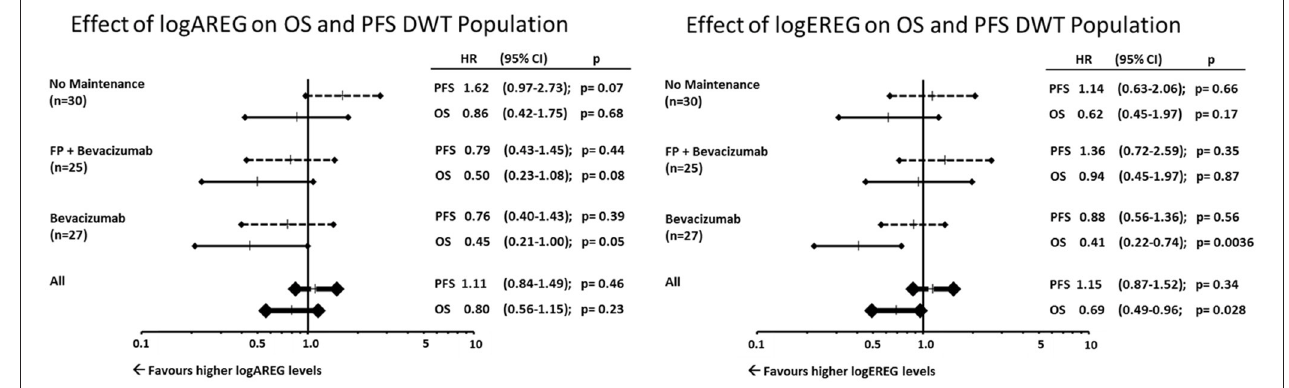
FIGURE 4 | Effect of logAREG on OS and PFS DWT population. Effect of logEREG on OS and PFS DWT